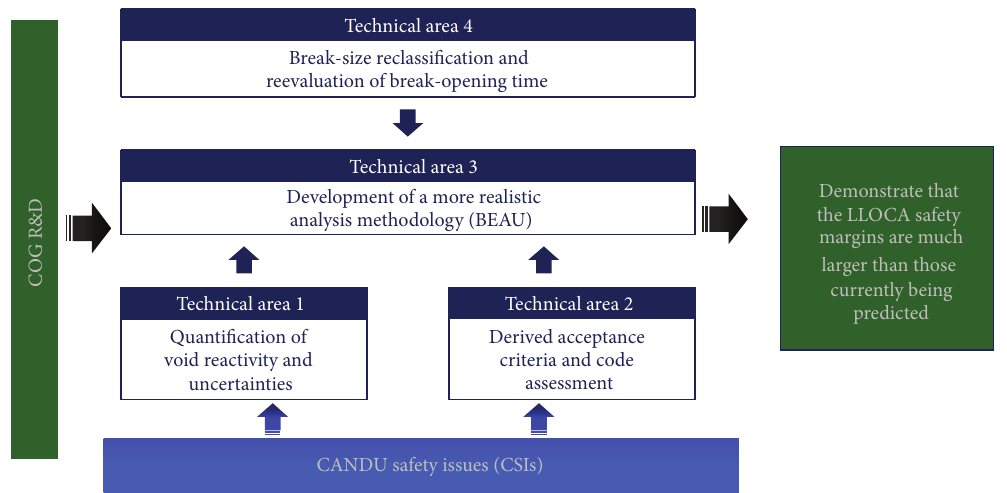
Figure 1: Illustration of composite analytical approach